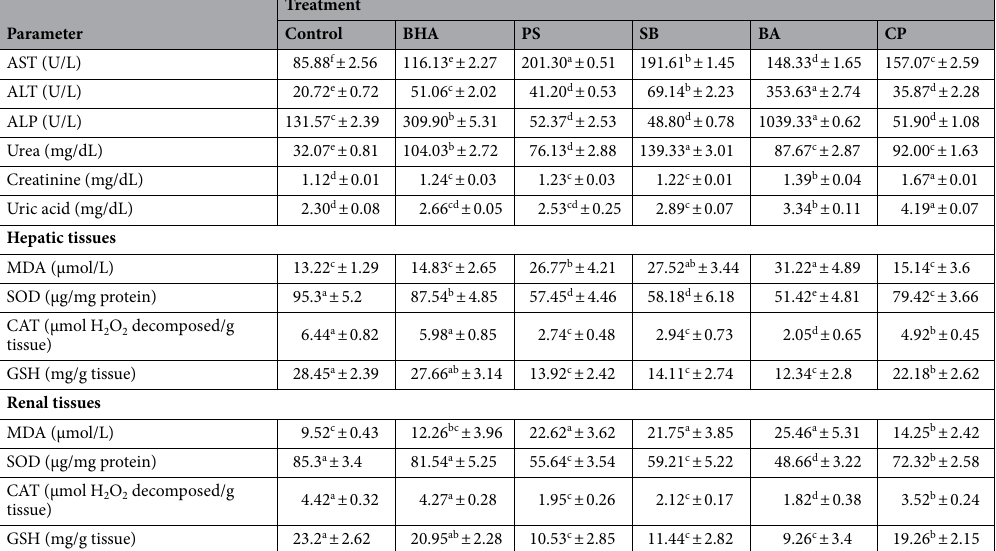
Table 2. Serum biochemical analysis and oxidative stress indices of hepatic and renal tissues of butylated hydroxyl anisole (BHA), potassium sorbate (PS), sodium benzoate (SB), boric acid (BA), or calcium propionate (CP)-treated rats. Control group: received distilled water. BHA group: 0.09 mg/kg b.wt. PS group: received 4.5 mg/kg b.wt. SB group: received 0.9 mg/kg b.wt. BA group: received 0.16 mg/kg b.wt. CP group: received 0.18 mg/kg b.wt. Rats were orally given all food preservatives for 90 days. AST aspartate transaminase, ALT alanine transaminase, ALP alkaline phosphatase, MDA malondialdehyde, SOD superoxide dismutase,